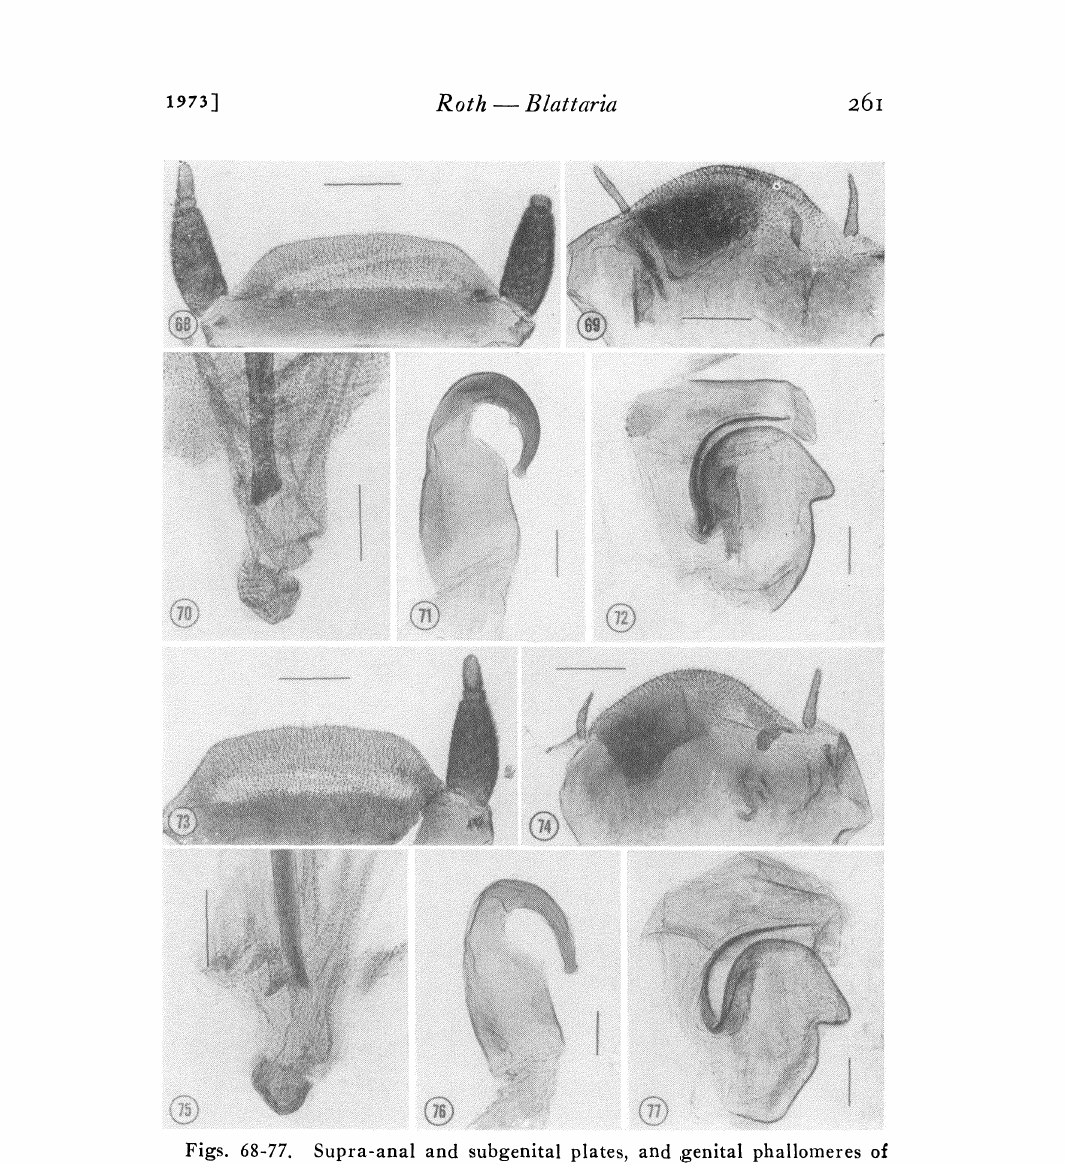
Figs. 68-77. Supra-anal and subgenital plates, and ,genital phallomeres of Dillotera spp. 68-72. (68 BMNH). Samoa Island. 68. Supra-anal plate (dorsal). 69. Subgenital plate (ventral). 70-72. Genital phallomeres. 73- 77. (69 BMNH). Henderson Island, South Pacific. 73. Supra-anal plate (dorsal). 74. Subgenital plate (ventral). 75-77. Genital phallomeres. (scale" supra-anal and subgenital plates 0.5 mm; phallomeres 0.2